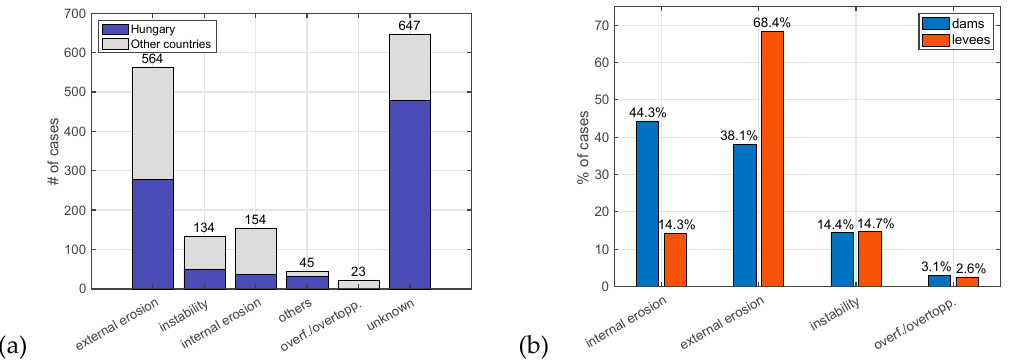
Figure 6. Statistics on ( a ) the observed failure mechanisms in ILPD ( b ) a comparison between earthen dams and levees for the most common failure mechanisms.